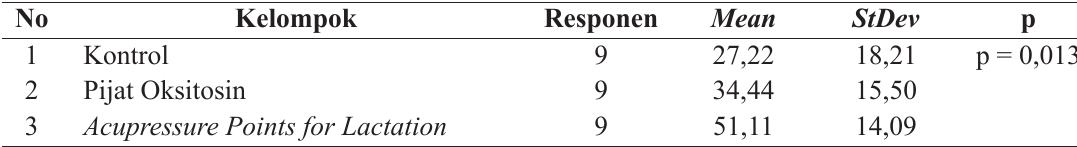
Tabel 4. Perbedaan peningkatan produksi ASI